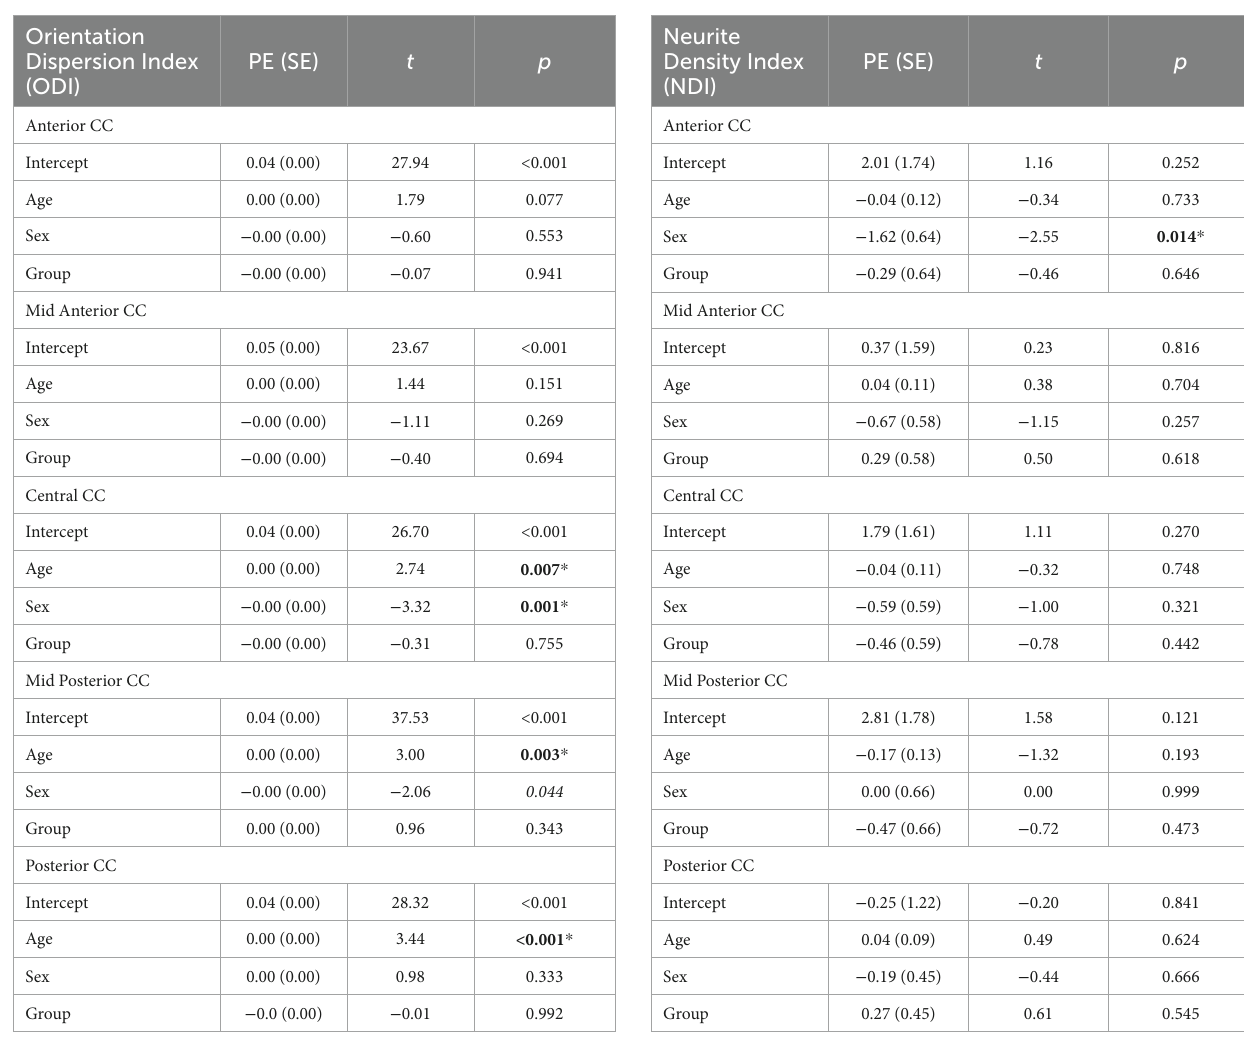
TABLE 4 Linear mixed effects model results for ODI. TABLE 5 General linear model results for SPC in